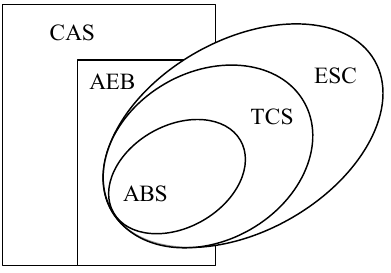
Figure 1. Relationship between all technologies of vehicle stability assistance.